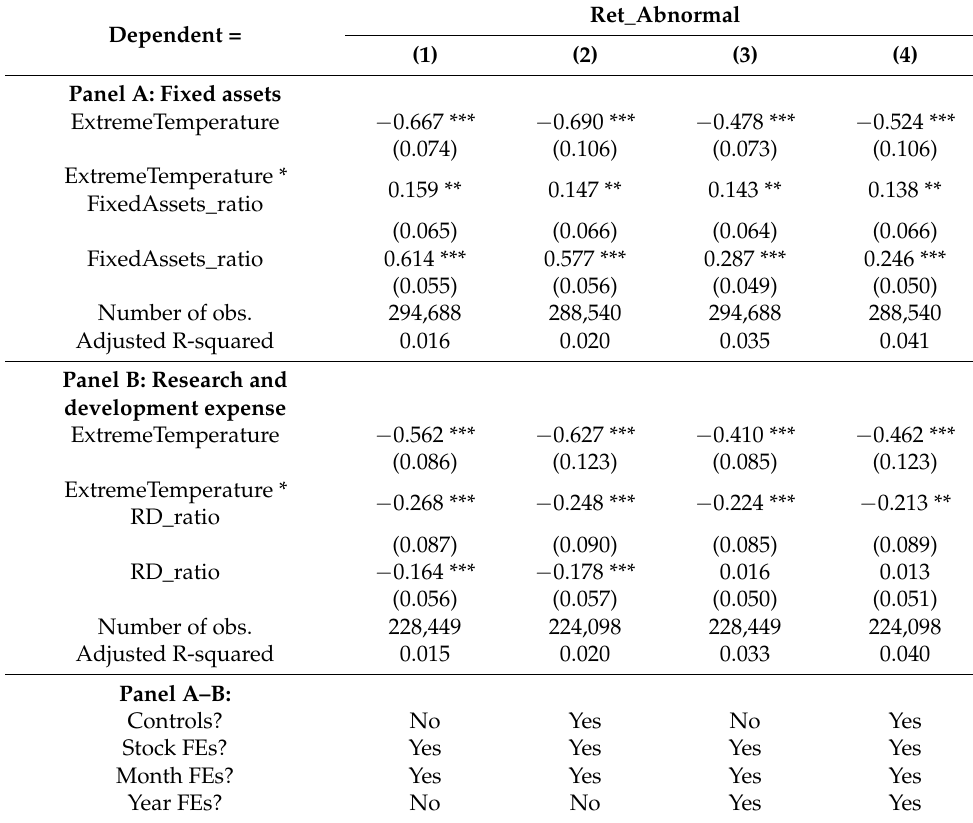
Table 6. The impact of extreme temperature across asset tangibility